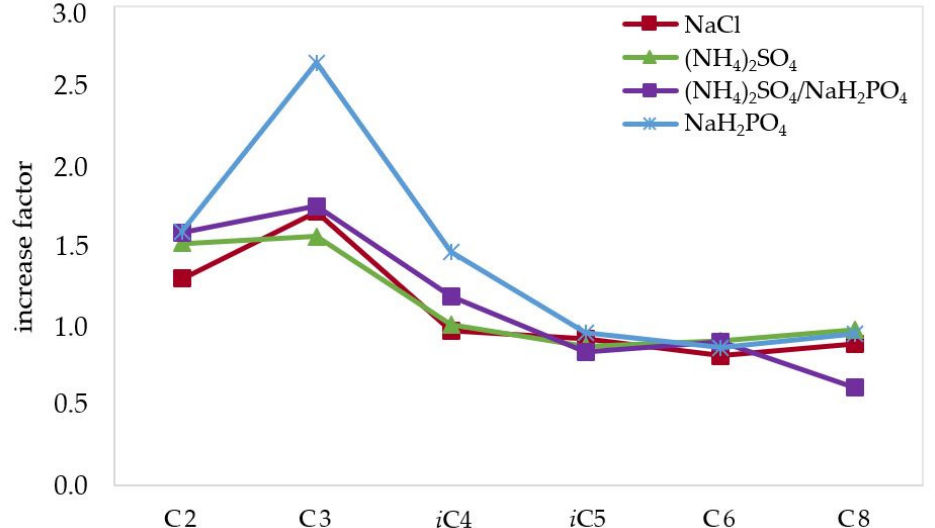
Figure 2. Increase factor calculated as the ratio between the mean peak area obtained from each SCFA and MCFA extracted from a wine sample (Nero D’Avola) using different salts and the mean peak area obtained without using salt.